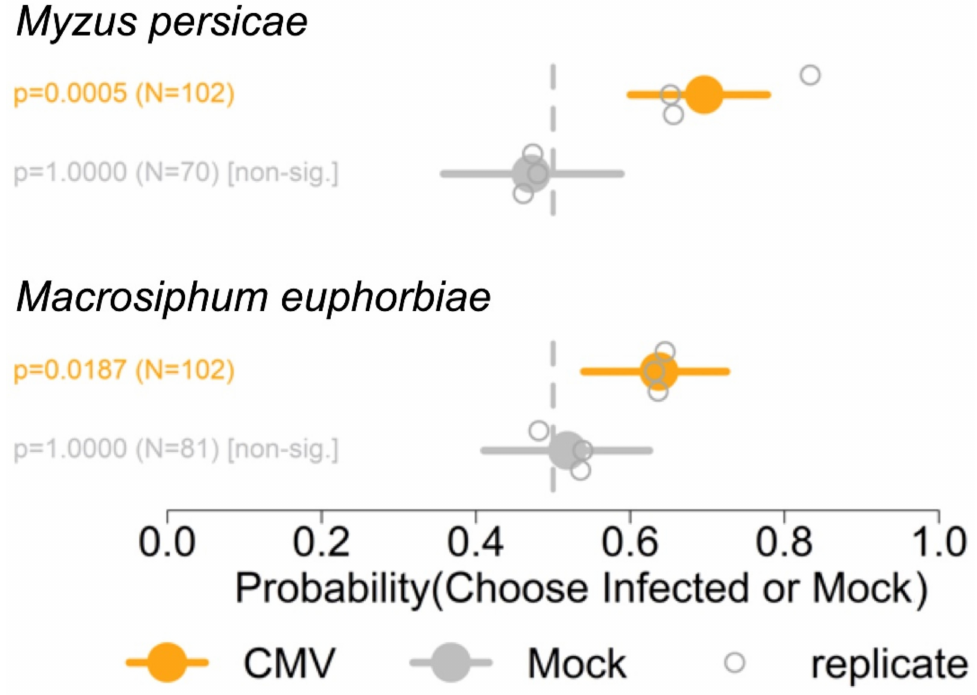
Figure 3. Summary of Y-tube olfactometry experiments to determine the preferences of aphids ( Myzus persicae and Macrosiphum euphorbiae ) for volatile organic compound blends emitted by mock- inoculated (Mock) tomato plants versus plants infected with cucumber mosaic virus (CMV, Fny starin) at 21 days post-inoculation. The x -axis shows the range of the 95% credible interval of the probabilities for preferences of aphids towards volatile organic compound blends emitted by infected or mock-inoculated plants. Three independent experiments (replicates) were carried out. The total number of aphids (N) observed for each comparison is indicated. The statistical significance or non-significance was determined using binomial tests. The vertical grey dotted lines indicate a probability of 0.5 of settlement on infected versus mock-inoculated plants, i.e., no preference for or against VOC blends of infected